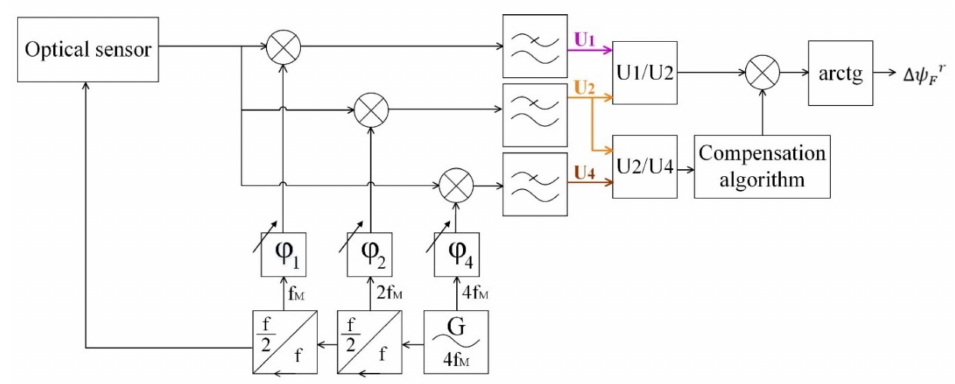
Figure 6. Block diagram of signal demodulation with compensation.